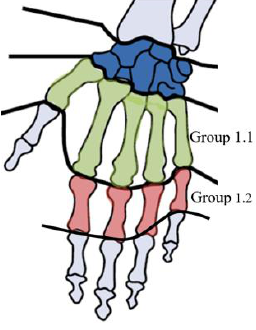
Figure 1. Diagram of levels of amputations groups. Figure 2. Bench test